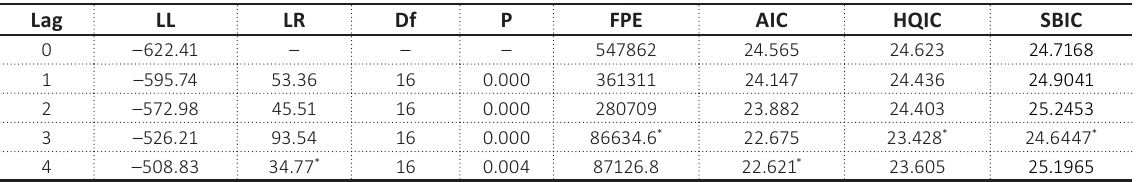
Source: Authors’ analysis